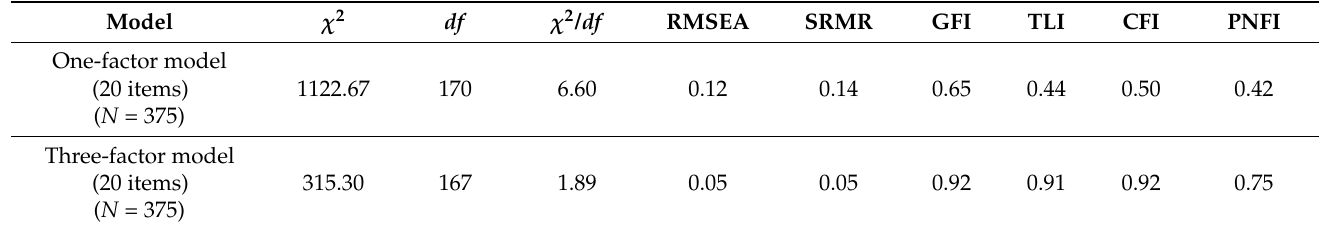
Table 2. Fit indices for the Tested Models (One-Factor and